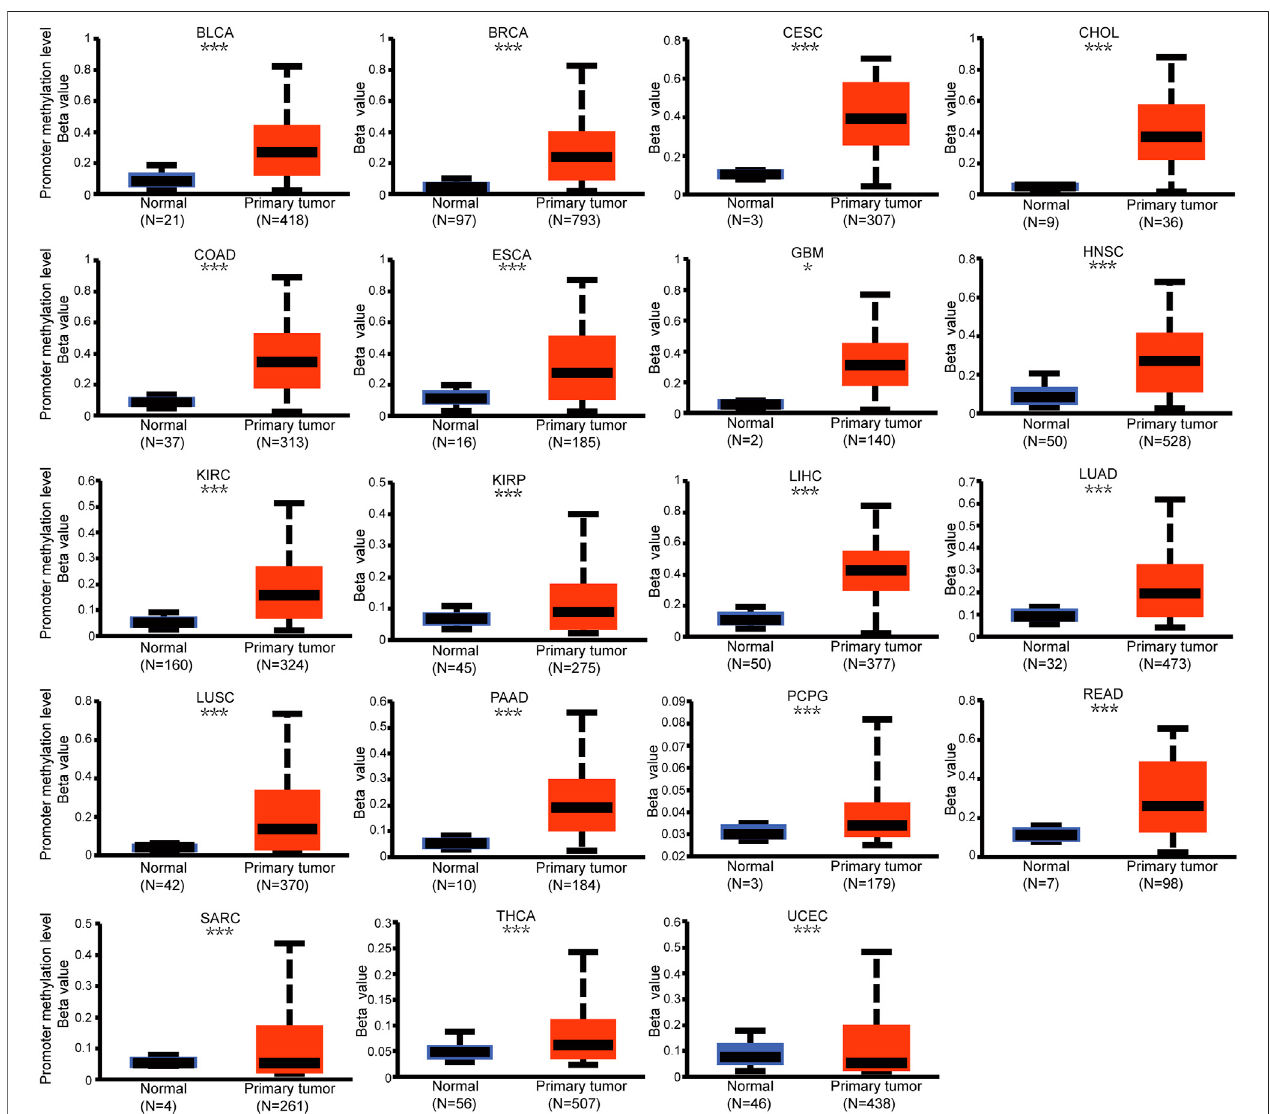
FIGURE 9 | Promoter methylation level of PPP1R14A in pan-cancer. The results were obtained from the UALCAN database. p , p < 0.05; pp , p < 0.01; ppp ; p < 0.001.